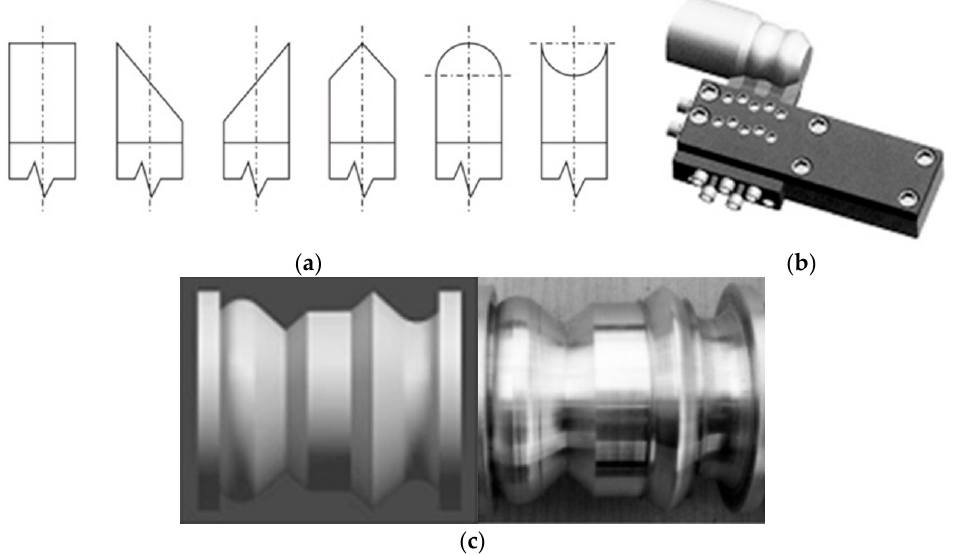
Figure 4. Multi-edge form tool with single cutting edges: ( a ) examples of single edges of the multi-insert form tool (geometry of cutting edge for each part from left to right (axial feed): k r = 90°, k r = 45°, k r = 45°, k r / = 45°, ε r = 90°, k r // =45°, r ε = 5 mm, and r ε = − 5 mm), ( b ) view of the virtual model of